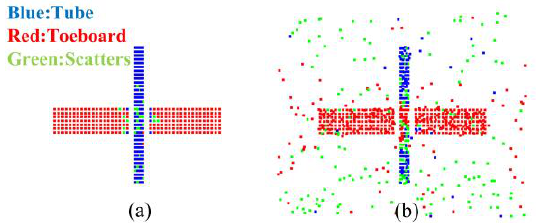
Figure 13. Classification results of synthetic point cloud. (a) Without noise. (b) With a noise level of 30%.